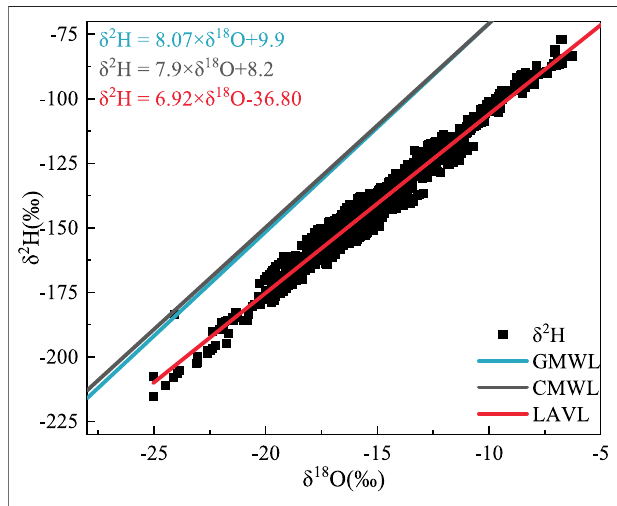
FIGURE 13 | Local atmospheric water vapor line of this study. The red line is the atmospheric vapor line fi tted by Lanzhou atmospheric water vapor δ 18 O and δ 2 H, the black line is Zheng Shuhui ’ s China meteoric water line, and the blue line is Gourcy ’ s global meteoric water